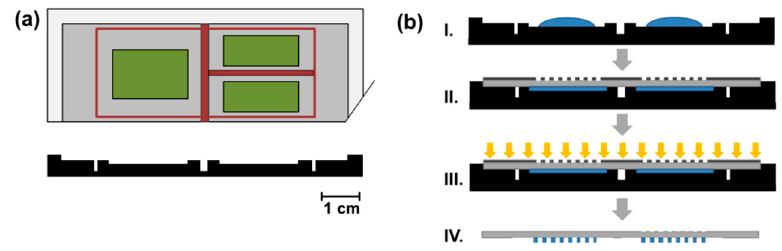
Figure 3. Production of spatially separated hydrogel dot arrays with a POM mould. ( a ) Scheme of the POM mould in the top view and side view. Colors indicate the three-dimensional structure of the mould. Green: chambers which are filled with the hydrogel precursor solution (depth: 100 µm), red: channels which serve as a drain for excess hydrogel precursor solution and prevent intermixing (depth: 3 mm), grey: surface where the glass slide is placed, white: boundary for the alignment of the glass slide (height: 1 mm). ( b ) Scheme of the polymerization process. Filling of the hydrogel precursor into the mould (I), alignment of glass slide and photomask (II), UV-irradiation (III), hydrogel dots on glass slide